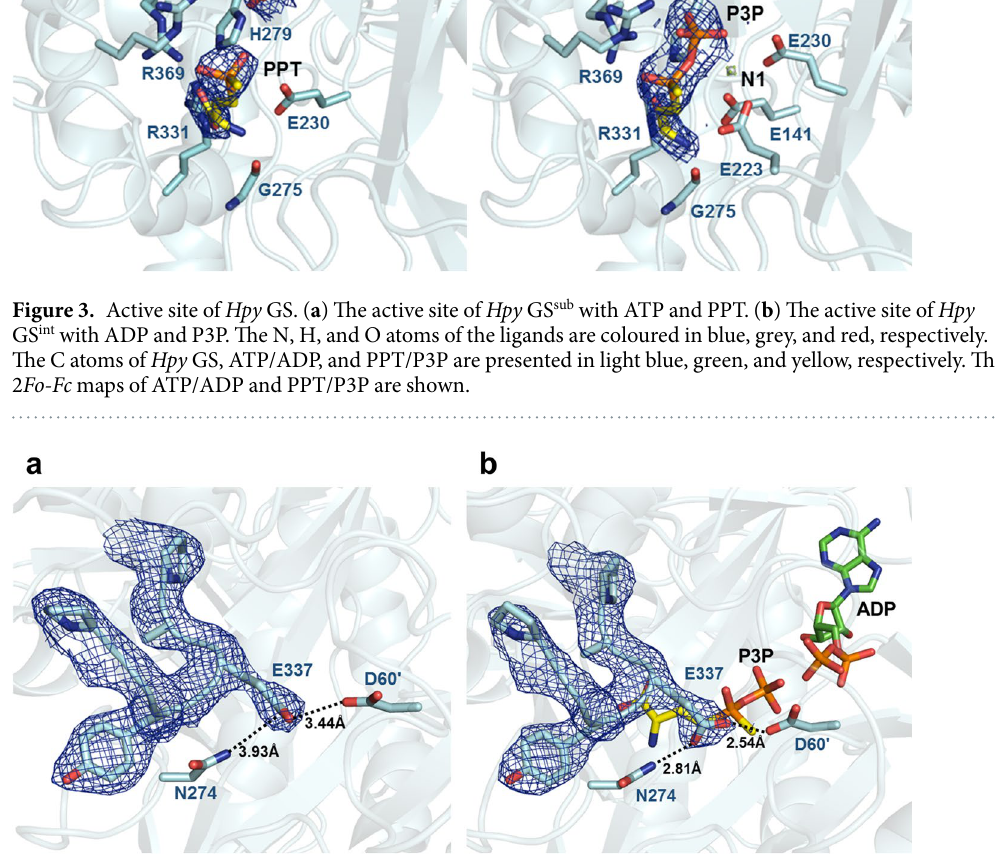
Figure 4. Entrance for glutamate in Hpy GS. ( a , b ) Show the entrance for glutamate in Hpy GS apo and Hpy GS int , respectively. The N, H, and O atoms of the ligands are coloured in blue, grey, and red, respectively. ADP and P3P are represented in green and yellow, respectively. Black dotted lines denote hydrogen